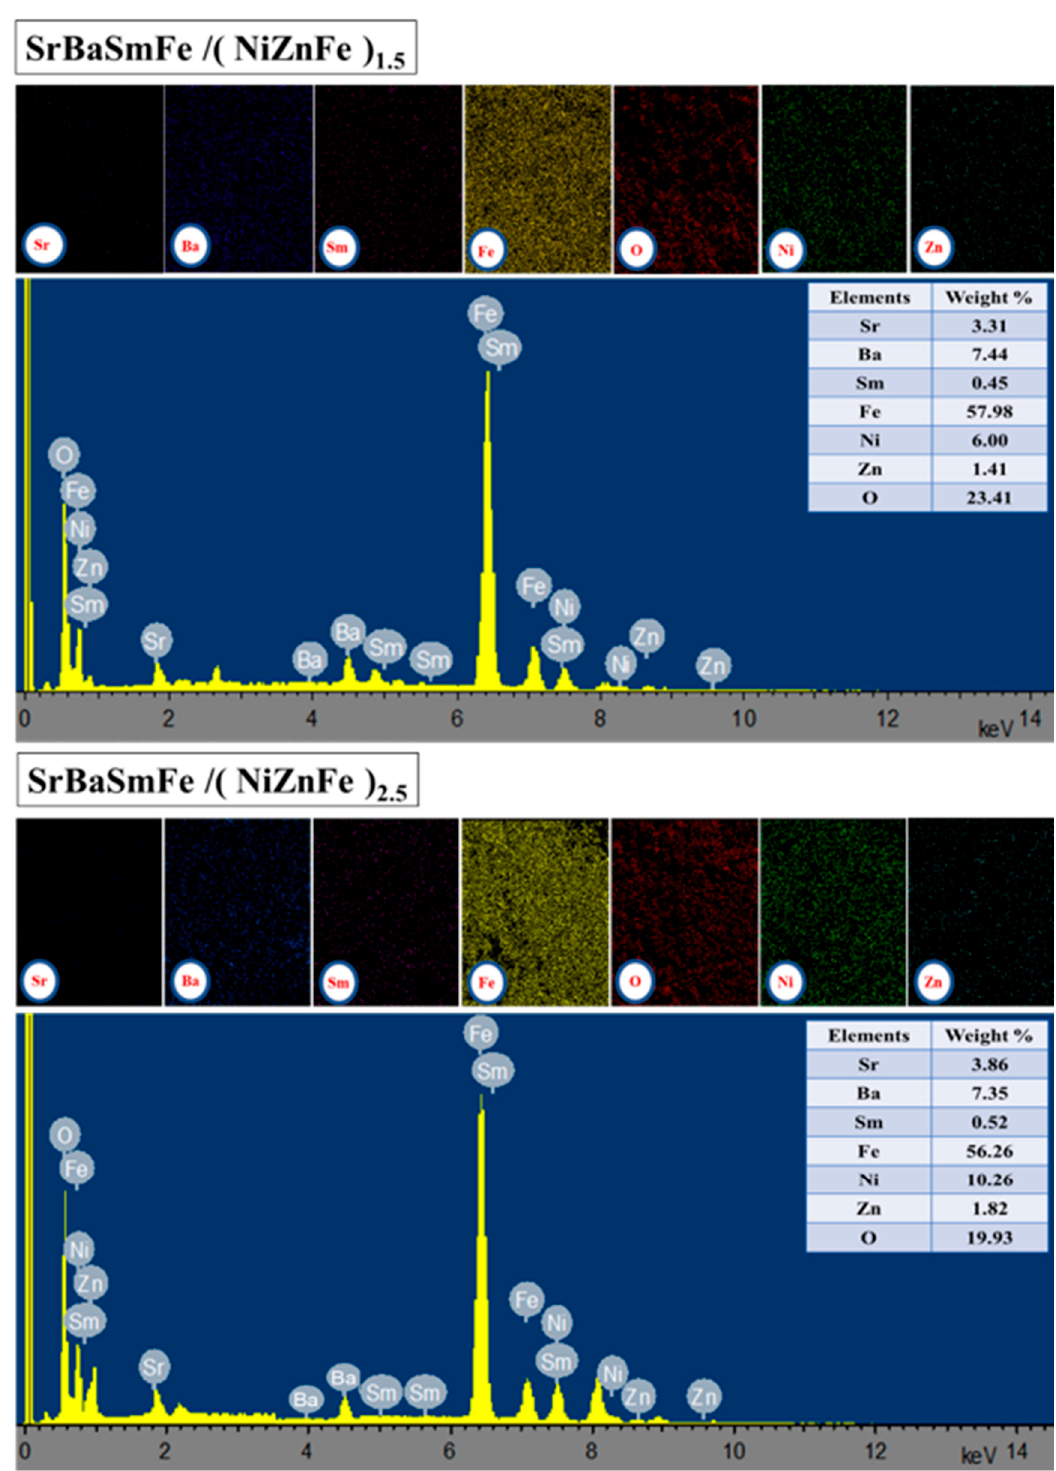
Figure 4. Energy-dispersive X-ray (EDX) and elemental mapping of hard/soft ferrite SrBaSmFe/(NiZnFe) x NCs with x = 1.5 and 2.5.